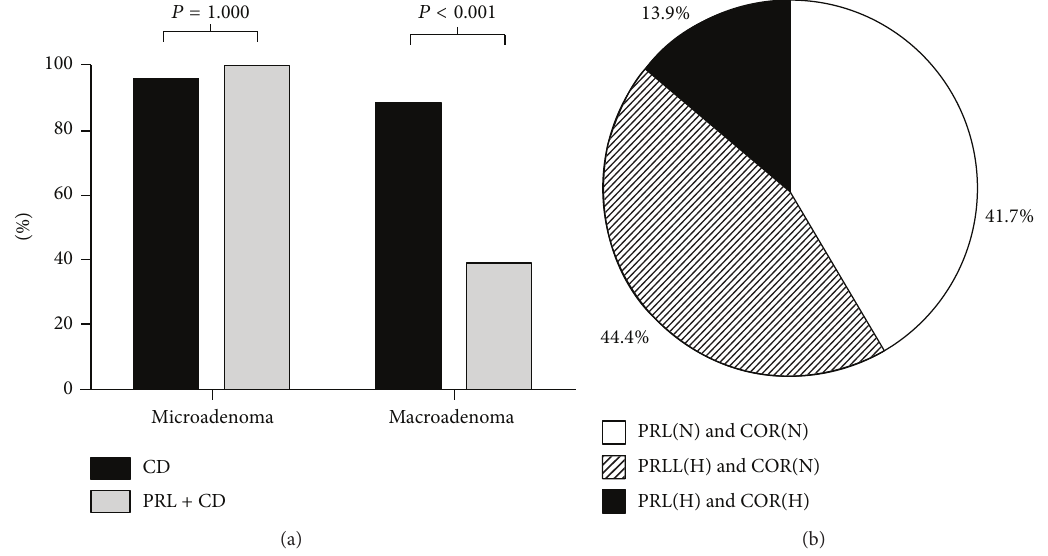
Figure 3: The rate of hormonal normalization in patients with Cushing’s disease. (a) Comparisons of the normalization rates (%) after transsphenoidal surgery between microadenomas and macroadenomas, for patients in the CD and CD + PRL groups. (b) Distribution of the hormonal normalization rate in the CD + PRL group. “H” indicates hormone levels above normal after surgery; “N” indicates hormone levels in the normal range after